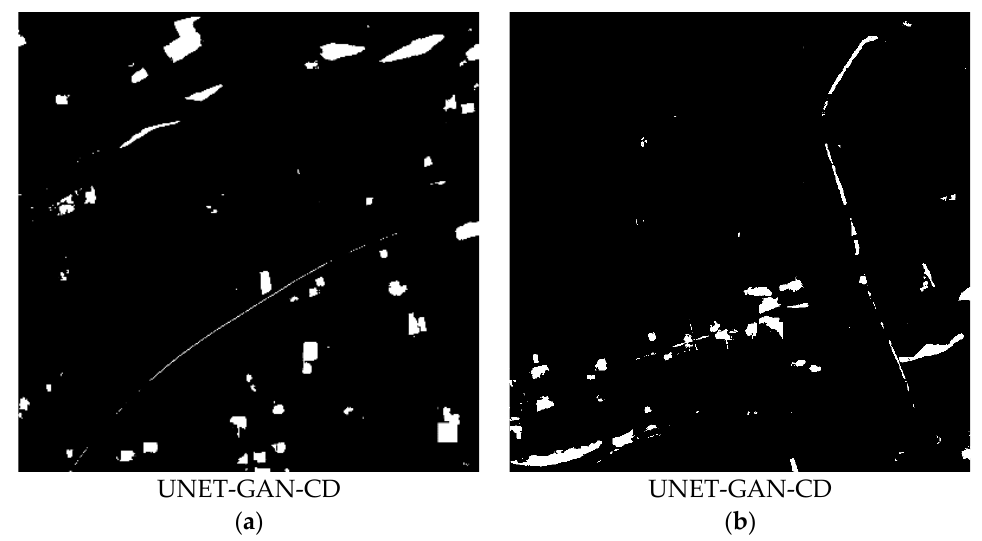
Figure 14. Change detection results: ( a ) detection results of image block 12 and ( b ) detection results of image block 8.